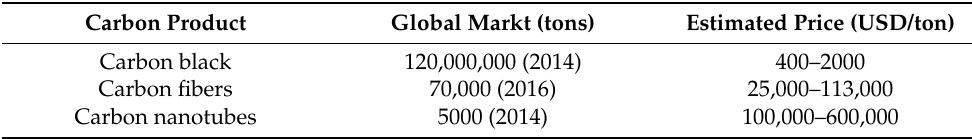
Table 2. Global market and estimated prices for solid carbon products